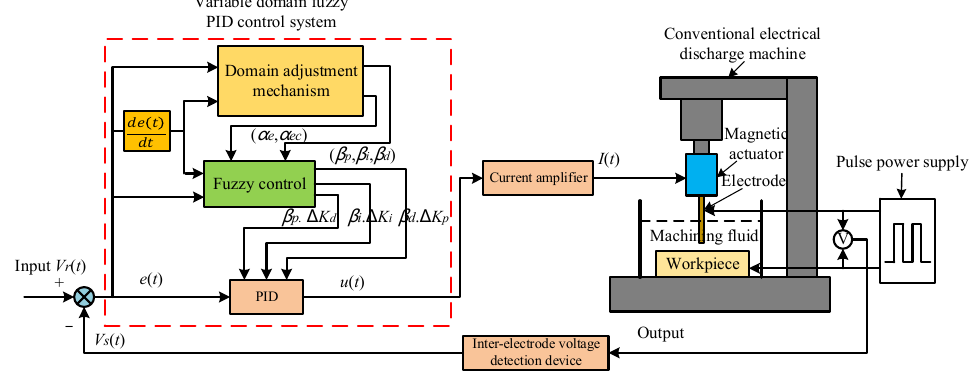
Figure 8. Magnetic actuator inter-electrode voltage control system with variable domain fuzzy PID.